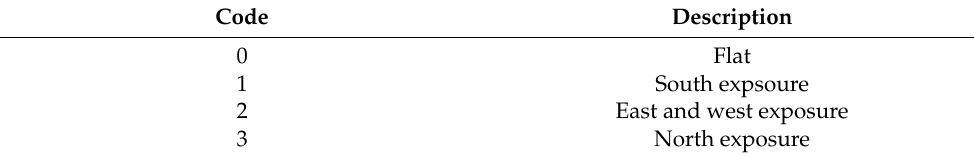
Table 3. Exposure